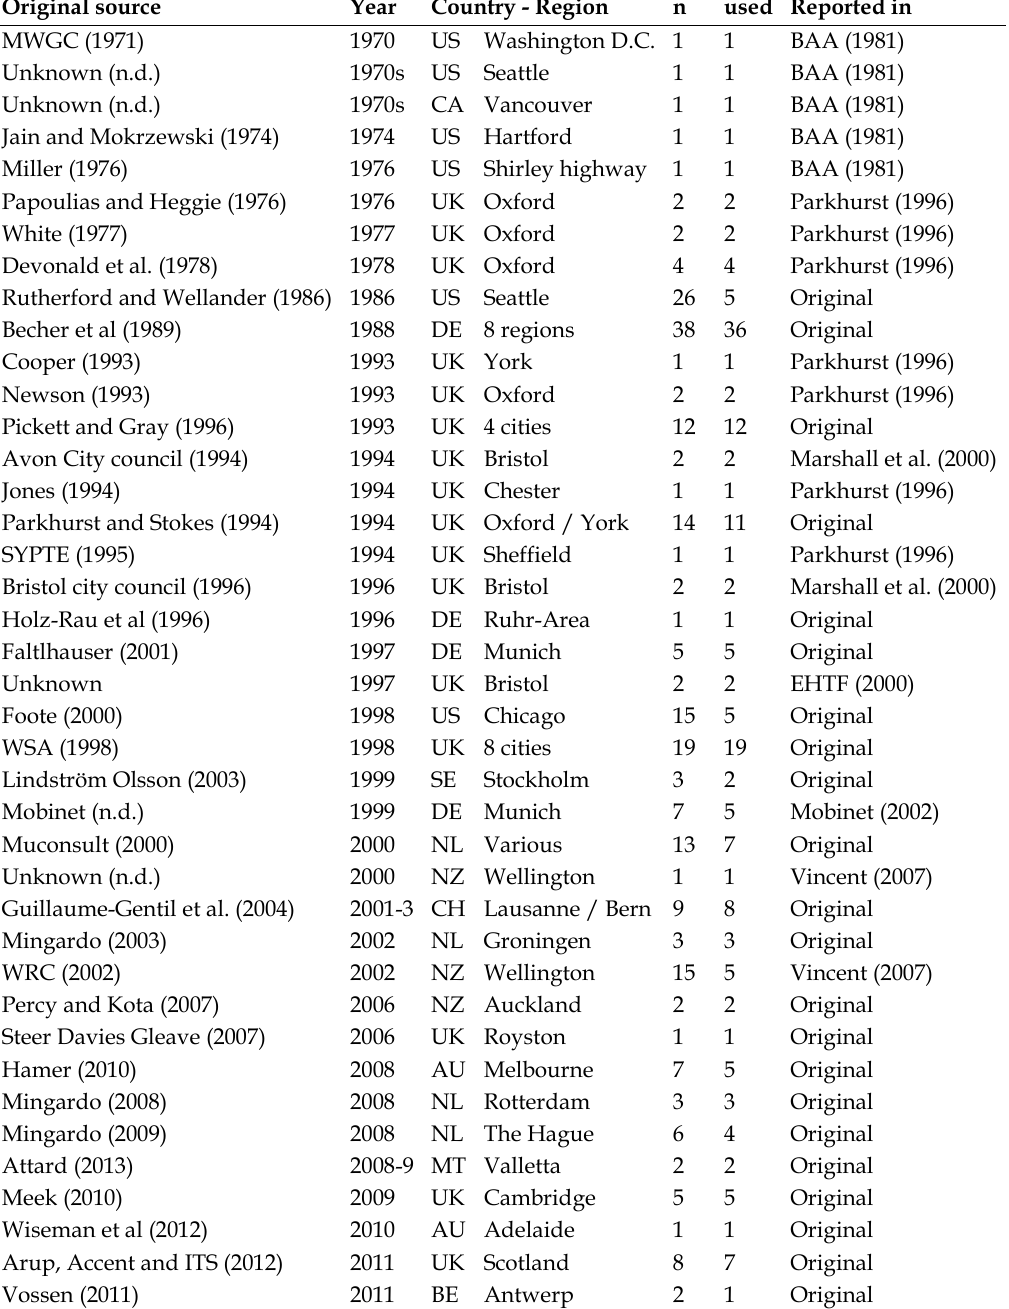
Table 1. Overview of the studies used in the